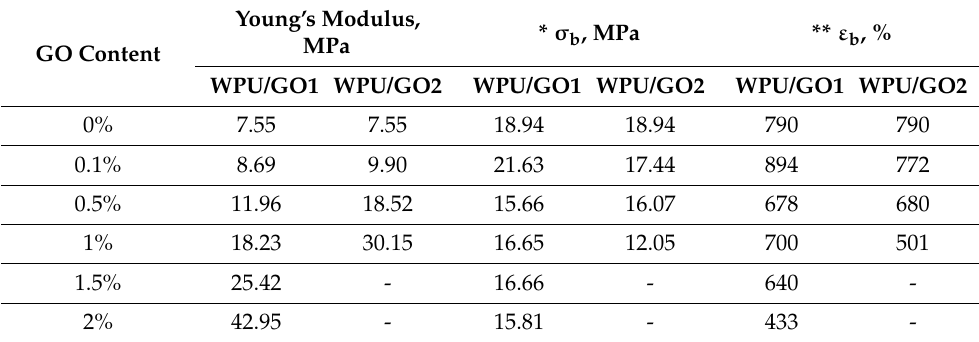
Figure 4. Stress–strain dependence for WPU/GO1 ( a ) and WPU/GO2 ( b ) samples. Table 2. Average numerical data of mechanical tests for WPU films and WPU/GO composites.